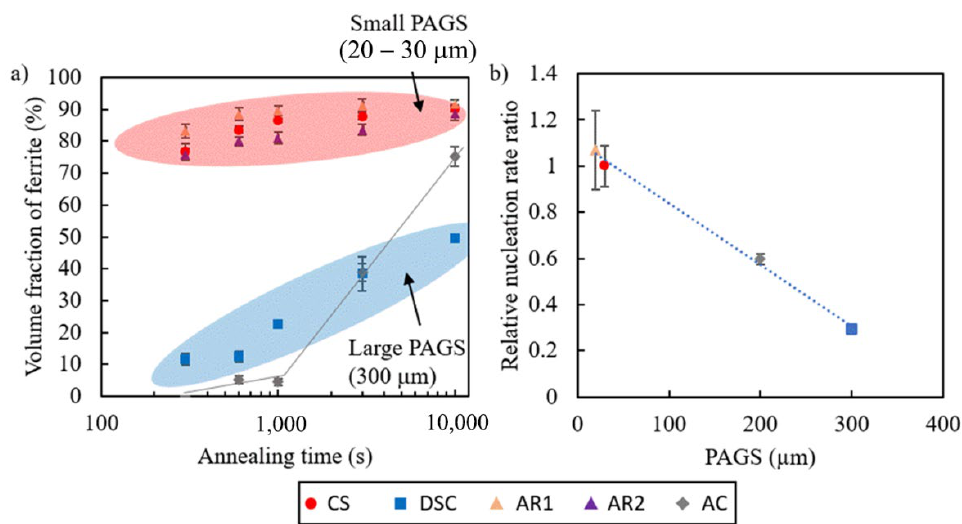
Figure 9. ( a ) Transformation kinetics grouped by prior austenite grain size; ( b ) Relationship between nucleation ratio and the prior austenite grain size (PAGS).